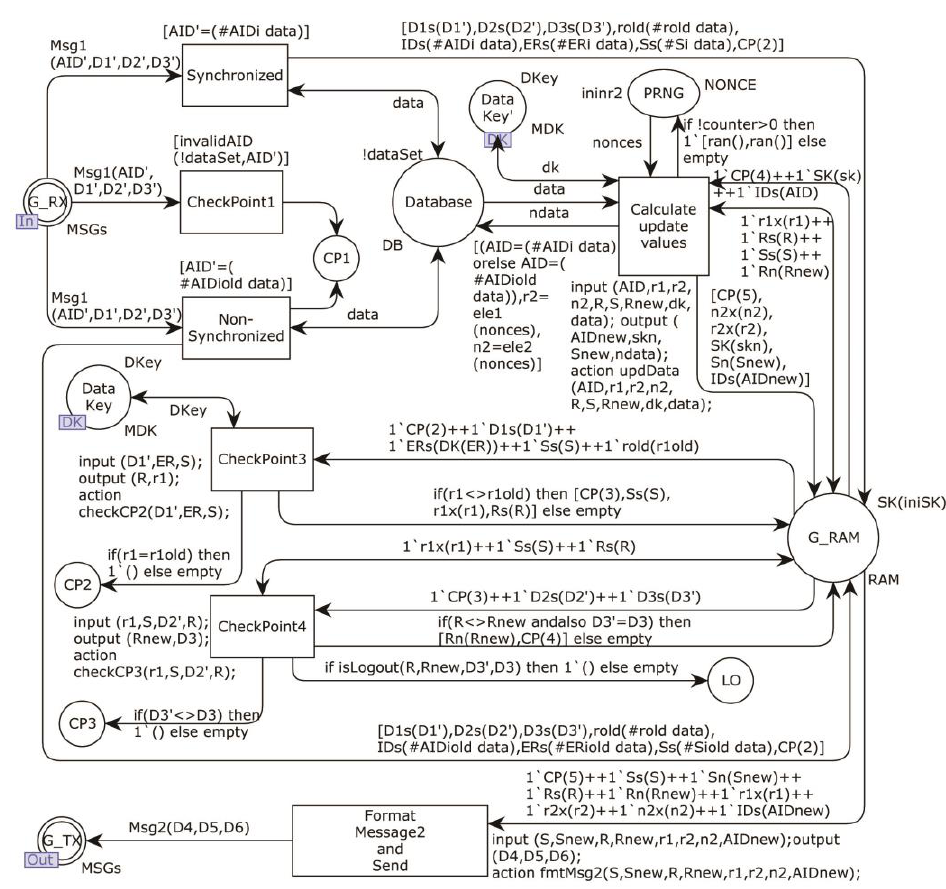
Figure 7. The Supervisor model subpage.